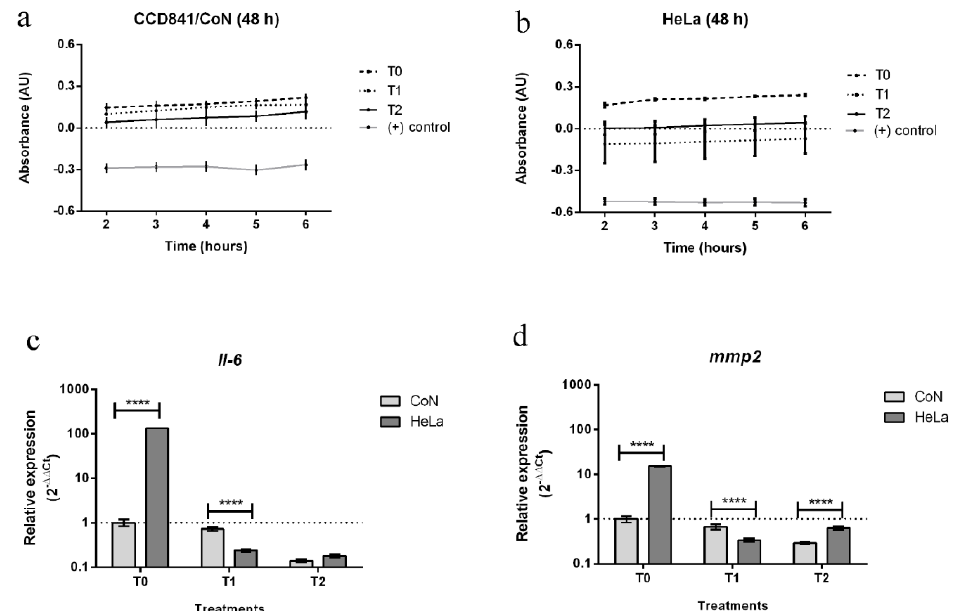
Figure 4. Biological activity of in vitro plant extracts. Resazurin colorimetric assay of: ( a ) control cell line, CoN; ( b ) HeLa cancer cell line. Relative fold change expression: ( c ) IL-6, ( d ) mmp2. All data represent the means of three independent replicates ± SD ( n = 9). The significance of difference was analyzed by Sidak’s multiple comparisons test ( p < 0.05); asterisks indicate significant differences compared with negative control under the same treatment conditions (**** p < 0.0001).